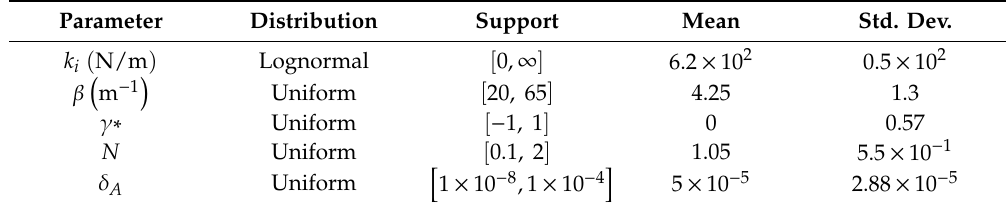
Table 5. Uncertain parameters of the BWBN model for the case study.